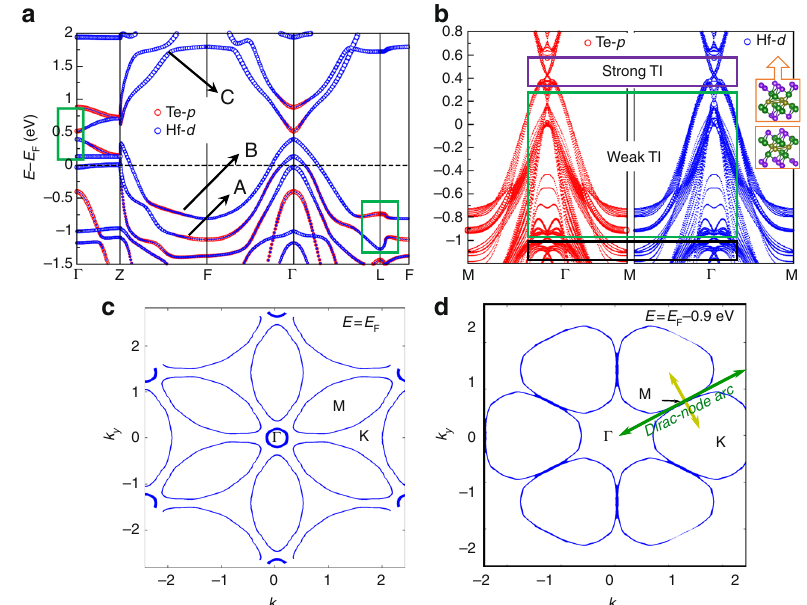
Fig. 4 Calculated multiple fermionic states. a The bulk electronic structure, calculated with spin-orbit coupling, along high-symmetry directions. Blue and red circles indicate the Hf- d and Te- p character of the band states, respectively. Band inversions are highlighted by the green rectangles. b Calculated surface states for the (111) surface with Hf and Te character indicated. The purple rectangle highlights the strong TI surface state stemming from bulk bands B and C whereas the green rectangle highlights the weak TI surface states due to bulk bands A and B. An additional gapless surface state is highlighted with a black box. c , d Calculated Fermi surface and constant energy contour 900 meV below the Fermi level, respectively. At 900 meV below the Fermi level, we observe a symmetry protected surface Dirac-node arc, denoted by the green